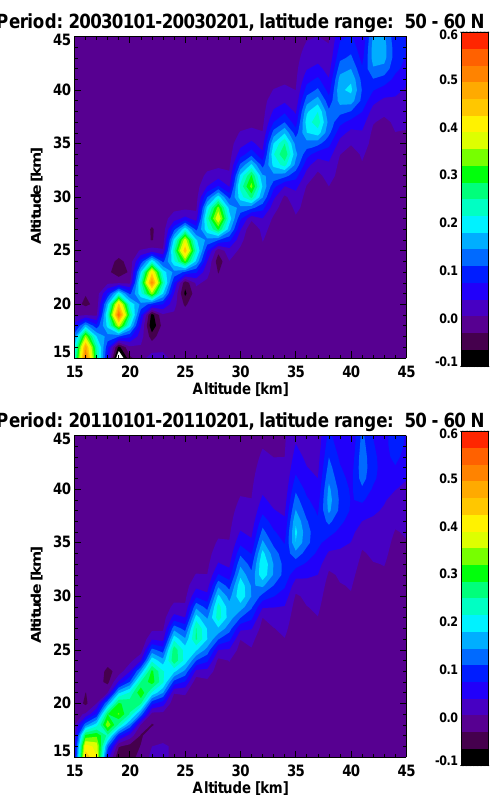
Fig. 2. Example of averaging kernels for SO 2 at mid-latitudes within the first (top) and the second (bottom) MIPAS measurement period.